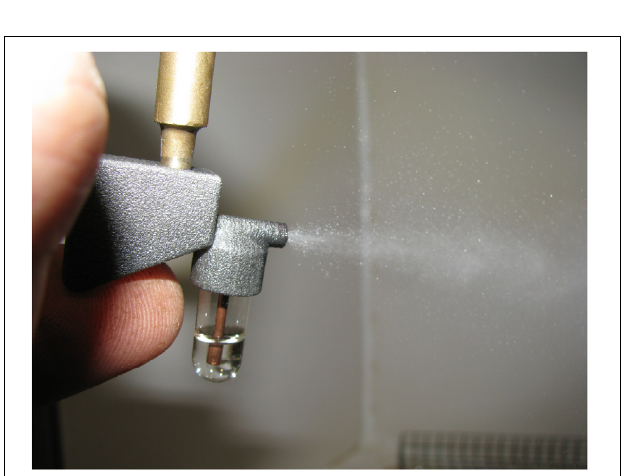
FIGURE 6 | Discharge of light mineral oil by an inoculator constructed with AM. The brass T-piece, which connects devices to either a vacuum or pressure pump, is also